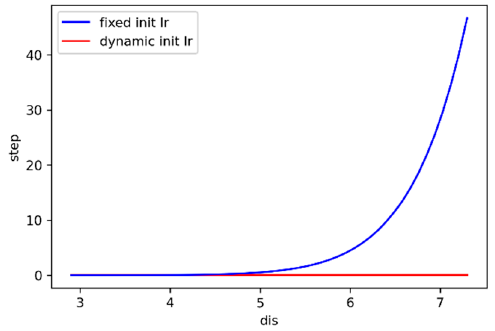
Figure 7. Relationship curve between the model input value and iteration step length.